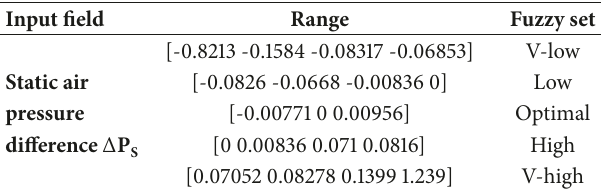
Table 4: MFs of static pressure difference ( Δ P S ).